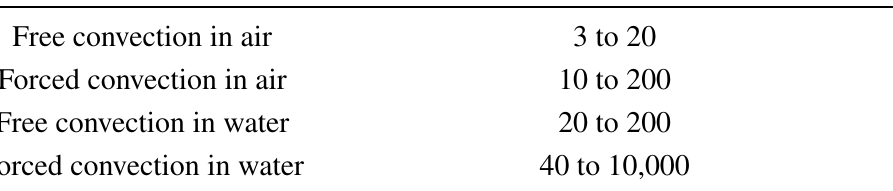
Table 1. Typical values for mean convective heat transfer coefficient